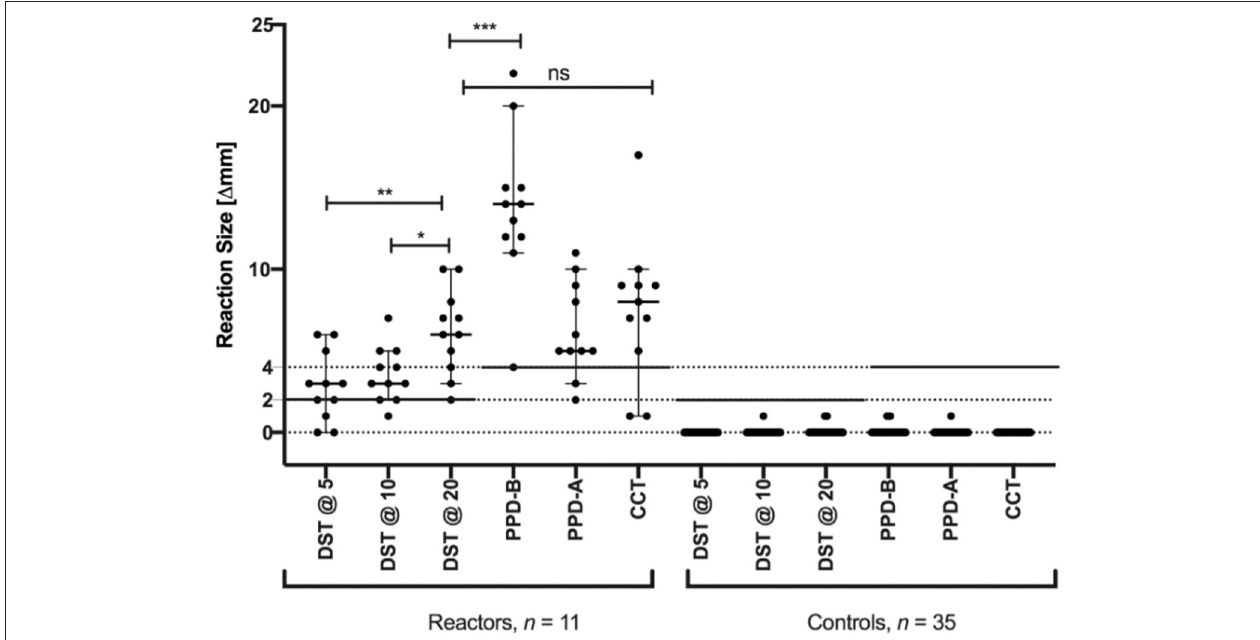
FIGURE 2 | Skin test responses for PPD-A, PPD-B and DST at three doses (5, 10, and 20 ug/ml). Responses were measured at 72h after injection in naturally infected ( n = 11) and naive control ( n = 35) buffaloes. Results are expressed as the difference in skin thickness (in millimeters) between the pre- and post-skin-test readings, with the horizontal line providing the median ( ± 95% CI). The statistical difference between the responses was determined using analysis of variance (ANOVA) (* P < 0.05; ** P < 0.01; *** P < 0.001). The solid horizontal lines at 2 and 4mm are the cut-offs used for DST, and CCT and PPD-B, respectively. The mean